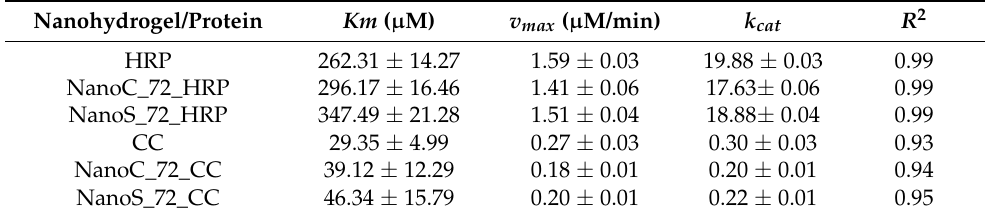
Figure 9. Peroxidase-like enzymatic activity of ( a ) free HRP, NanoC_HRP and NanoS_HRP; ( b ) free CC, NanoC_CC and NanoS_CC. The measurements were performed in triplicate. Table 6. Kinetic parameters of peroxidase-like enzymatic activity assay for free enzymes and CC/HRP loaded NanoC and